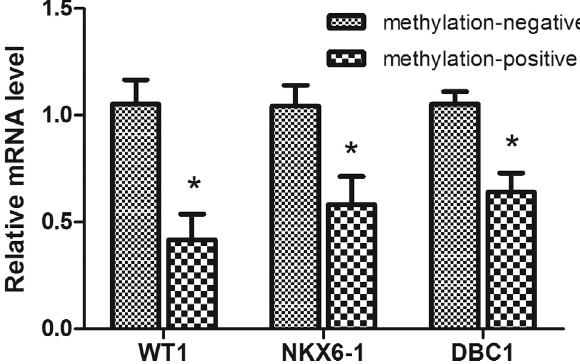
Figure 3 - Expression of the WT1, NKX6-1 and DBC1 genes in 10 methylation-positive tissues and 10 methylation-negative tissues. (cid:5) -actin served as internal control. Note: * statistically significant compared with methylation-negative group, P < 0.05.